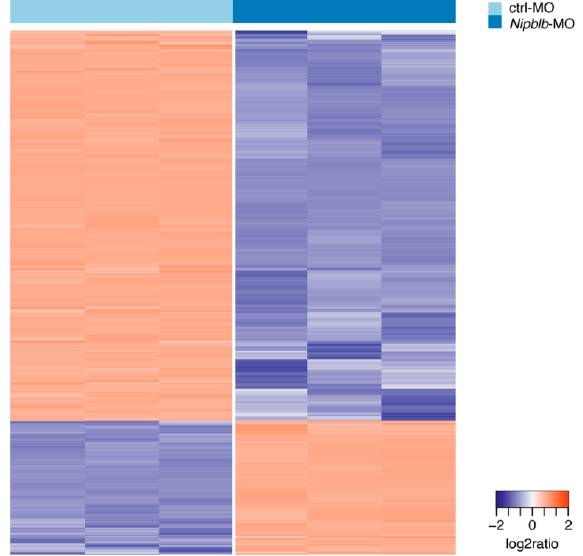
Figure 2. Hierarchical clustering of ctrl-MO and nipblb -MO-injected embryos based on the standardized gene expression values of 5338 genes differentially expressed in the comparison between nipblb -MO and ctrl-MO embryos at 24 hpf. Each column represents one separated biological sample.